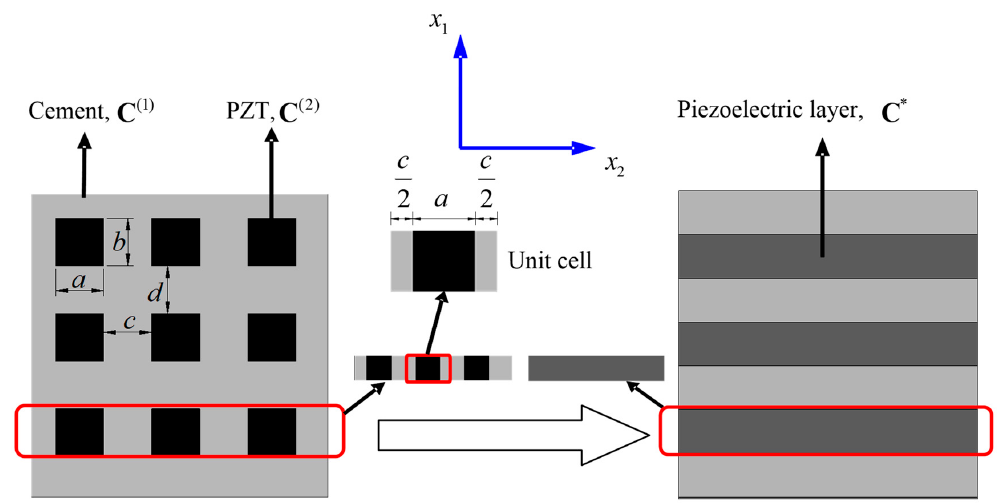
Figure 10. First homogenization of the 1-3 cement-based piezoelectric composite.